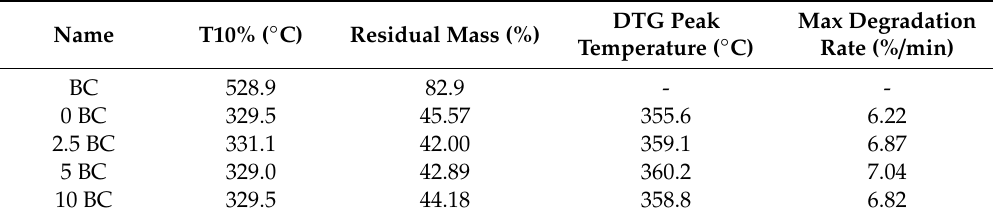
Table 5. Results of TGA analysis for composites and biochar examined in air